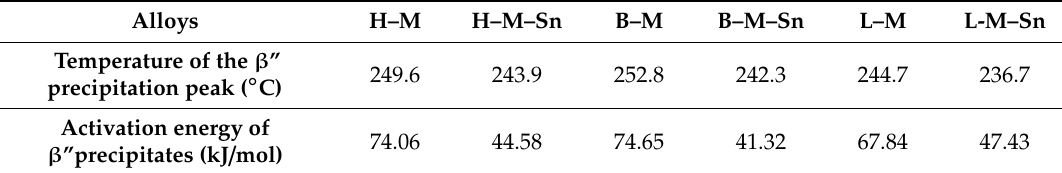
Table 4. Precipitation peak temperature and activation energy of β ” precipitates in six investigated